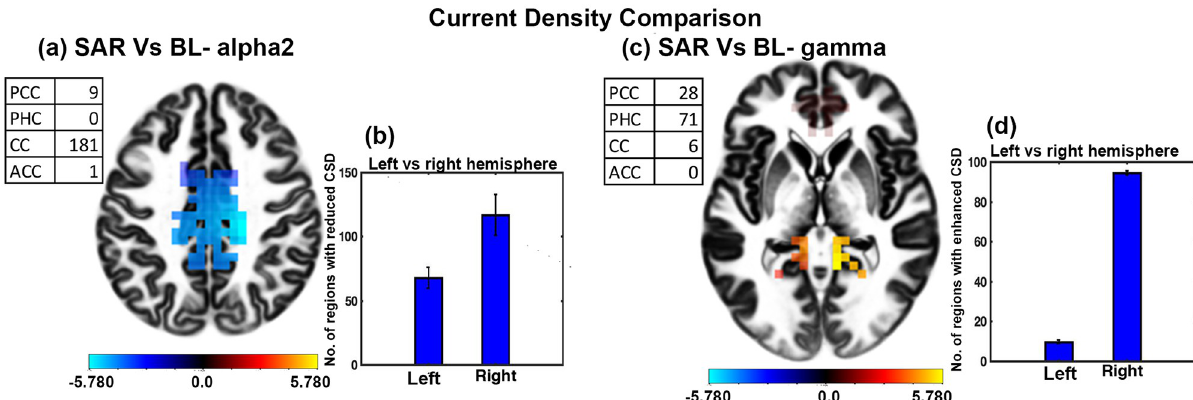
Fig 4. CSD analysis for SAR condition and baseline state. (a) Slice frontal view representation of the brain regions depicting the change in the CSD in the alpha2 band (b) The hemispheric difference concerning the number of brain regions having significantly reduced CSD under SAR condition compared to the baseline state. (c) Slice frontal view representation of the brain regions depicting the change in the CSD in the gamma band (d) The hemispheric difference concerning the number of brain regions having significantly enhanced CSD under SAR condition compared to the baseline state. (error bars = 1 SD).